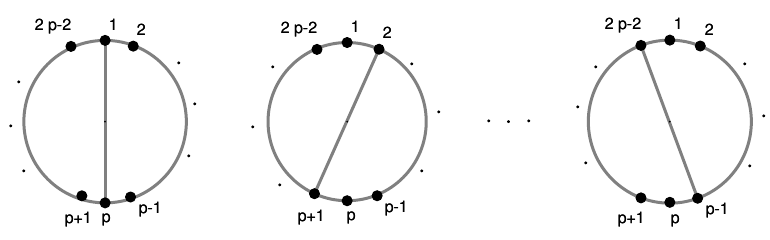
Figure 1 . The di(cid:11)erent p -angulations of a (2 p (cid:0)